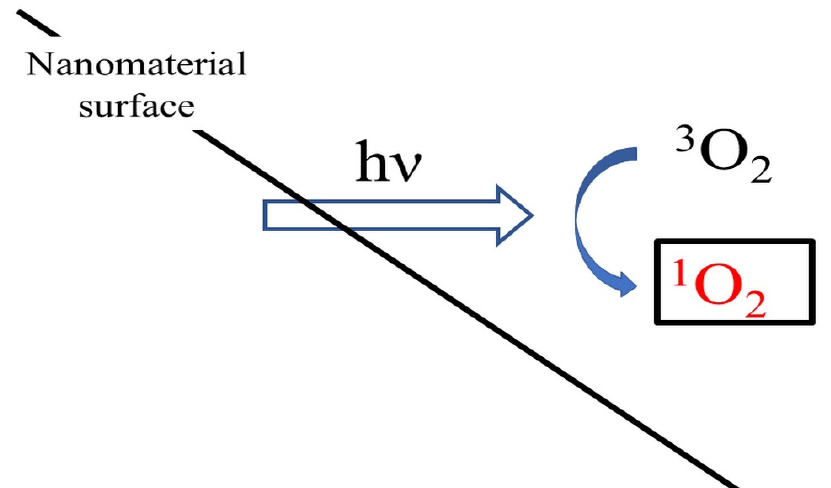
Figure 3. Generation of 1 O 2 in a photocatalytic reaction on the TiO 2 surface. Abbreviations: 3 O 2 = molecular oxygen; 1 O 2 = singlet oxygen; and h ν = radiation.